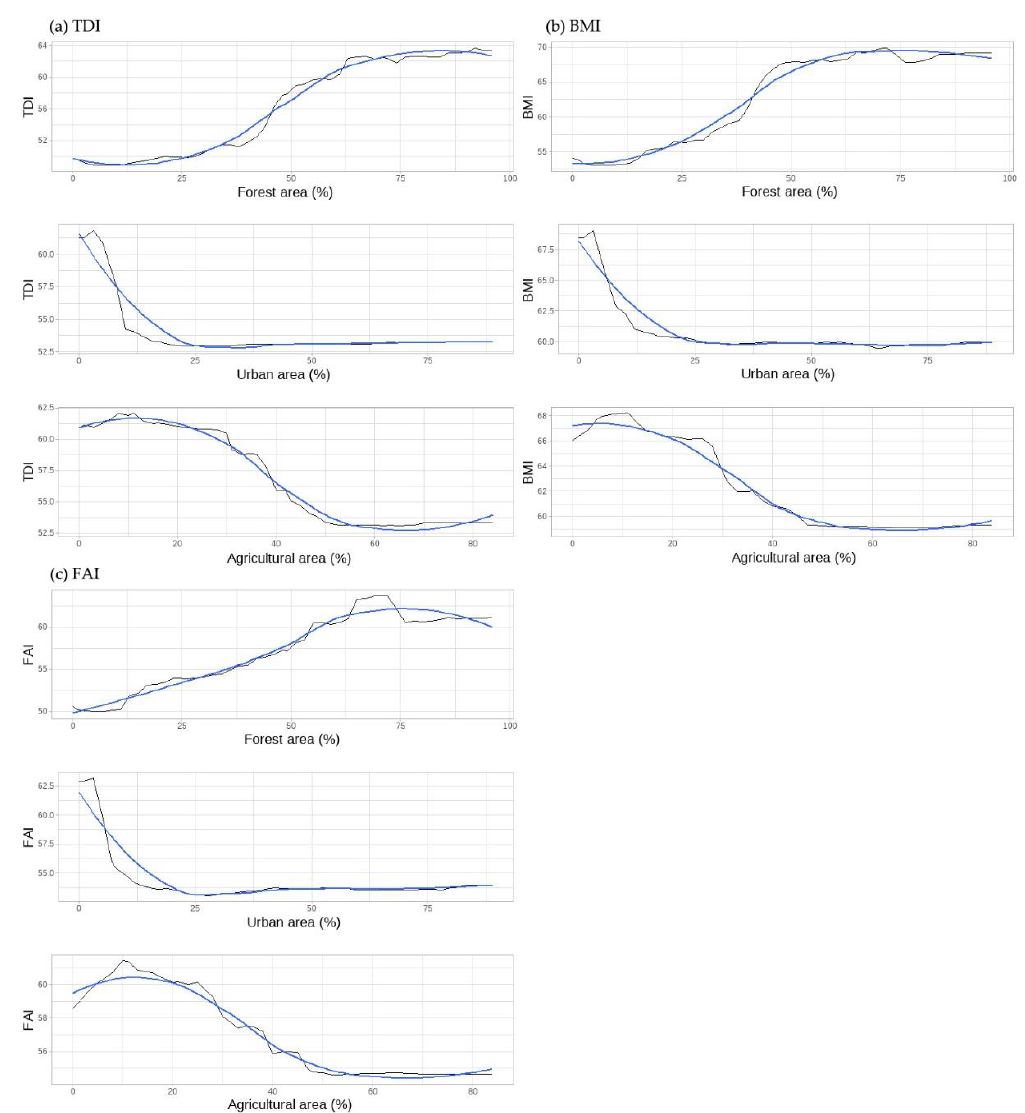
Figure 4. Partial dependence plots (black curves): ( a ) TDI; ( b ) BMI; and ( c ) FAI, based on random forests. Smooth curves are shown in blue.